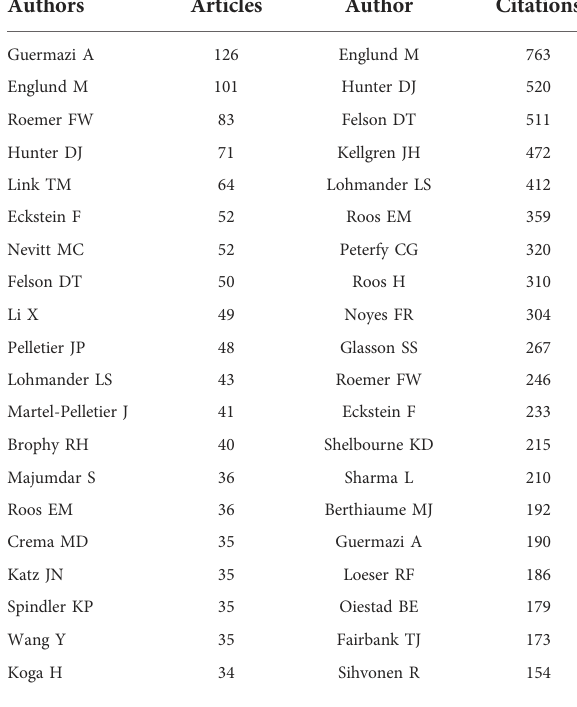
TABLE 1 The top 20 authors with the most papers and